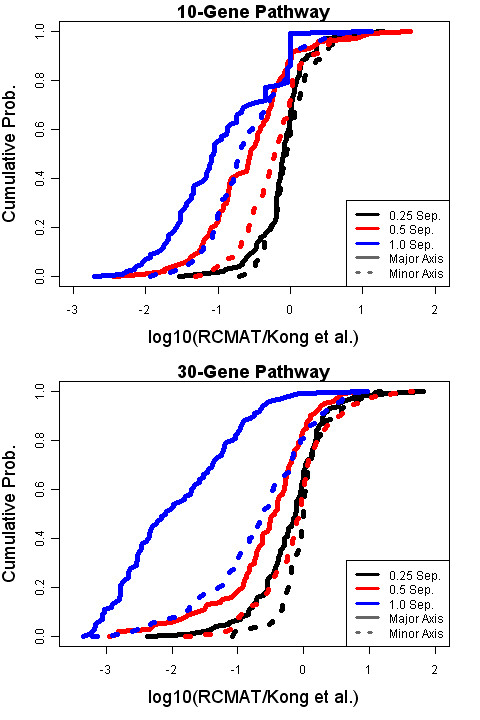
Cumulative distribution function of a ratio of RCMAT and Kong et al. p-values under several simulated non-null conditions. For 12 non-null conditions 100 simulation experiments were performed and permutation p-values obtained for both the RCMAT and the method of Kong et al. The logarithm base ten of the RCMAT p-value/Kong et al. p-value ratio is listed on the horizontal axis. The vertical axis is the cumulative distribution function, the proportion of values less than the observed ratio, for the 100 simulated data sets within a condition.